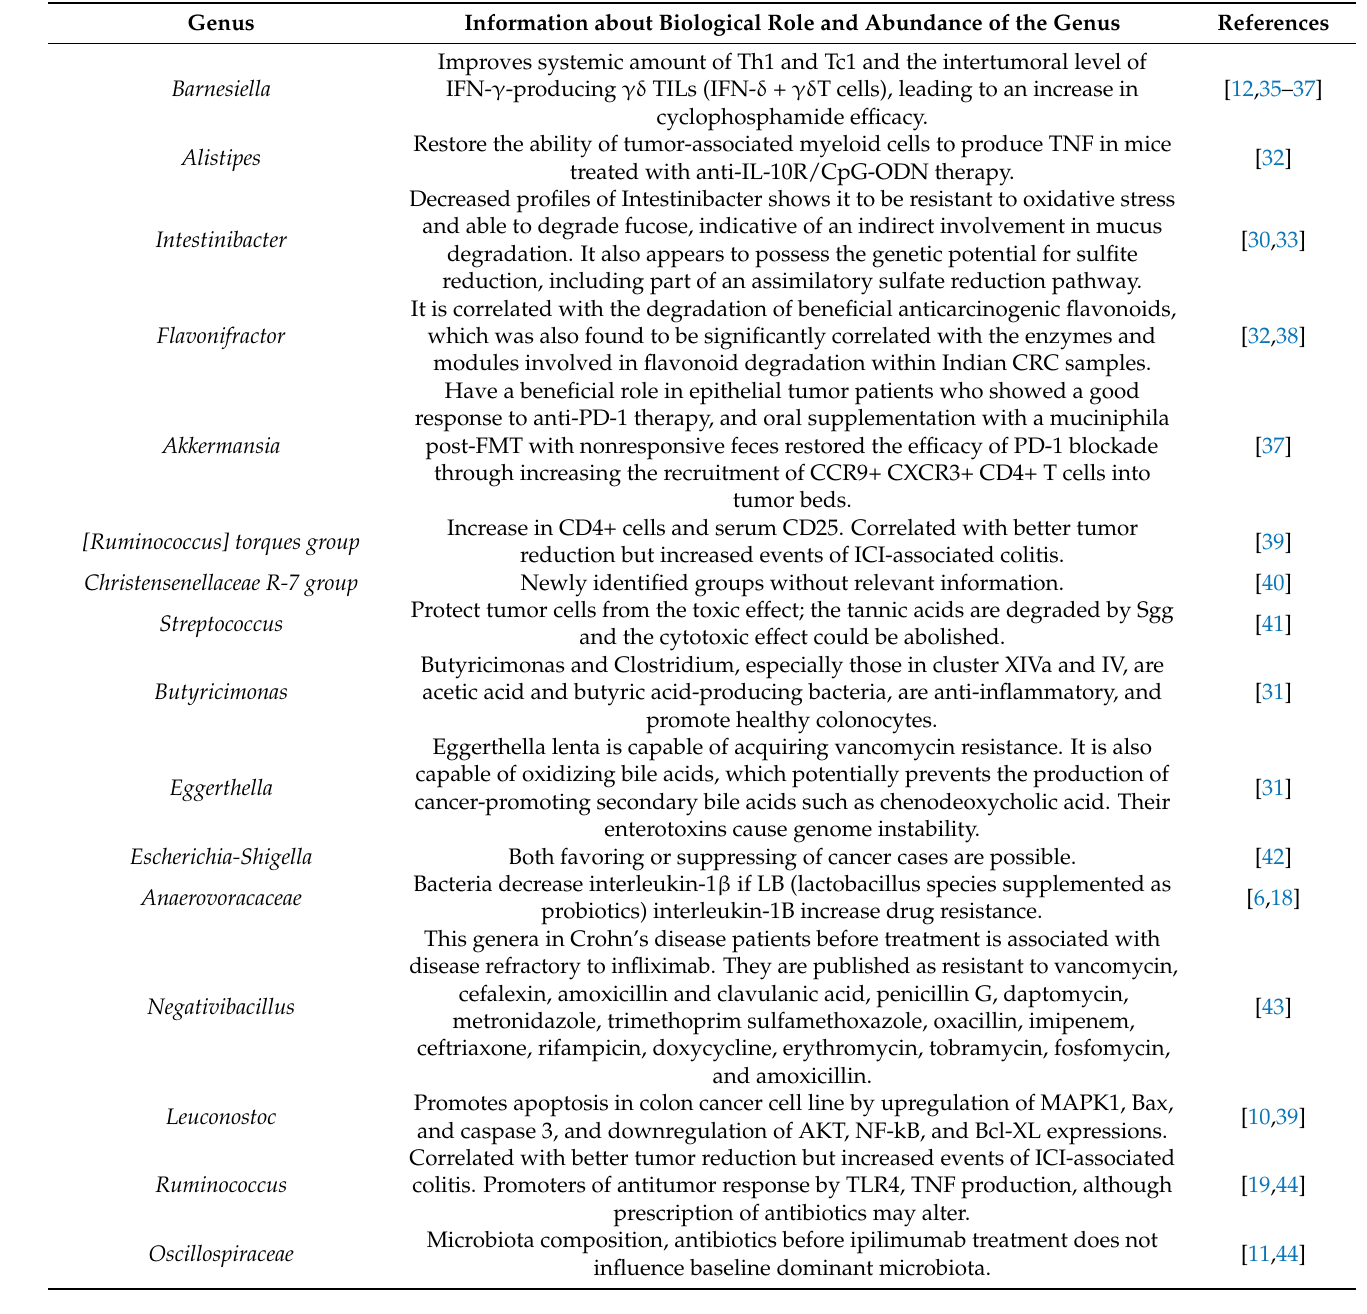
Table 7. Summary of the resistance mechanism bacteria